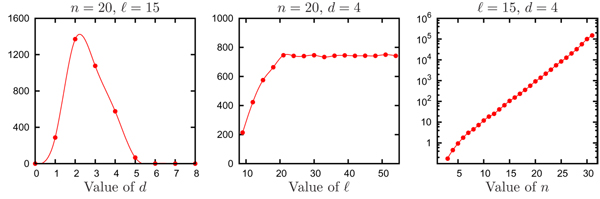
Efficiency of rejection sampling. Average number of rejections when generating a pairwise bounded set with our rejection sampling heuristic. Each plot shows the effect of varying one of the three parameters (n, ℓ, d). Data points are connected with cubic splines. Note the logarithmic scale used in the right plot.